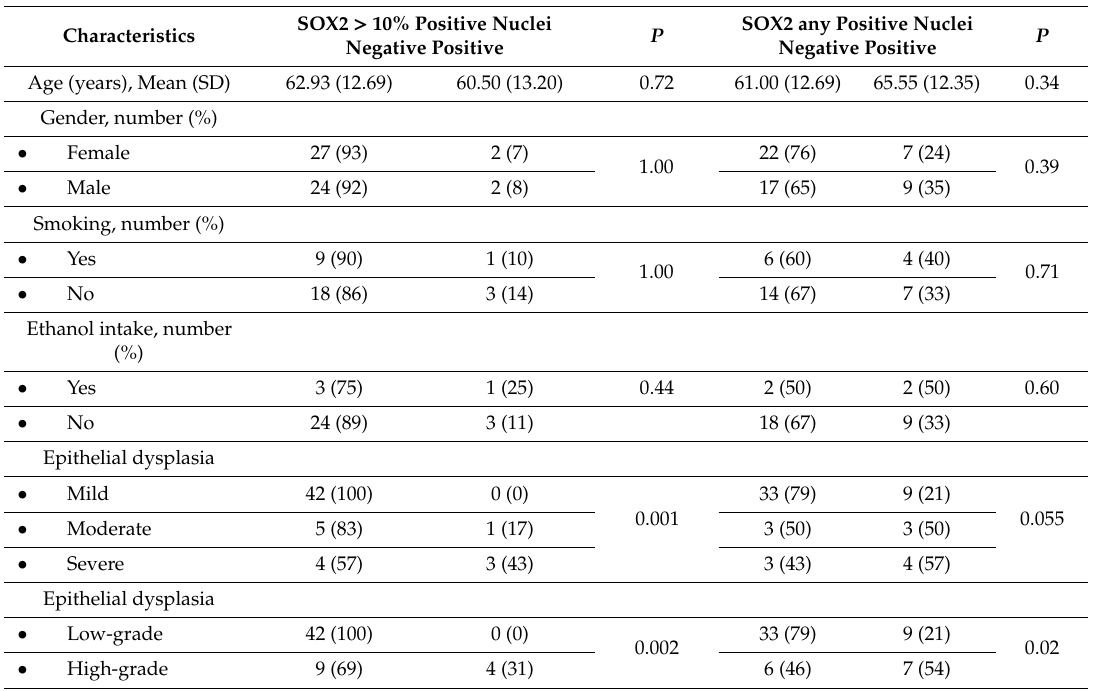
Table 1. Associations between SOX2 expression and patient